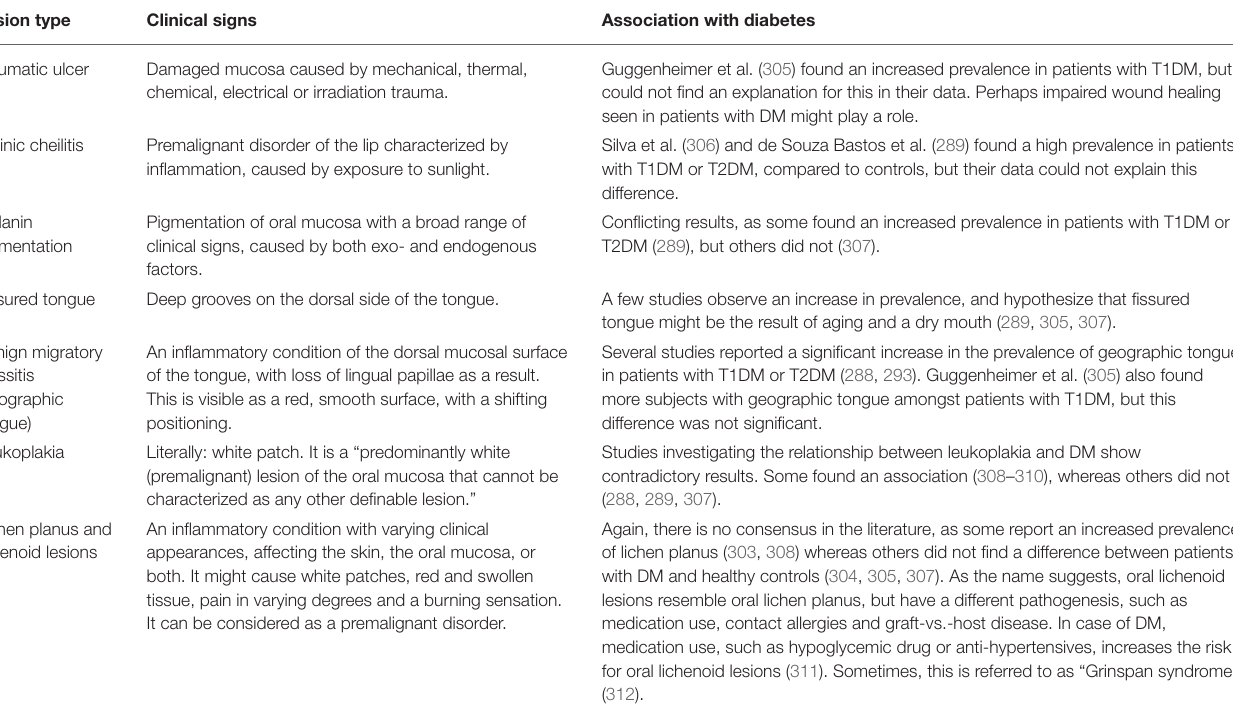
TABLE 4 | Overview of non-candidal lesions that are possibly associated with diabetes mellitus. Lesion